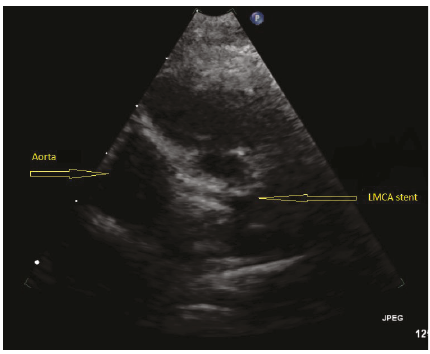
Figure 3: Post-PCI transthoracic echocardiogram demonstrating widely patent stent in the